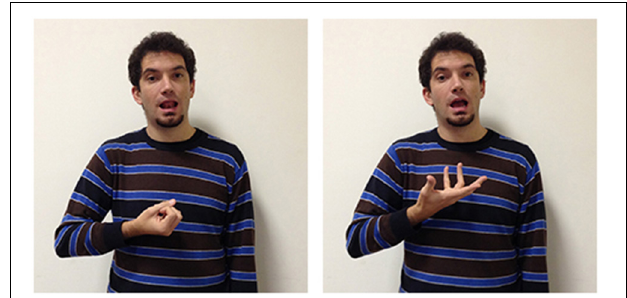
FIGURE 15 | LIS sign LINGUISTICS